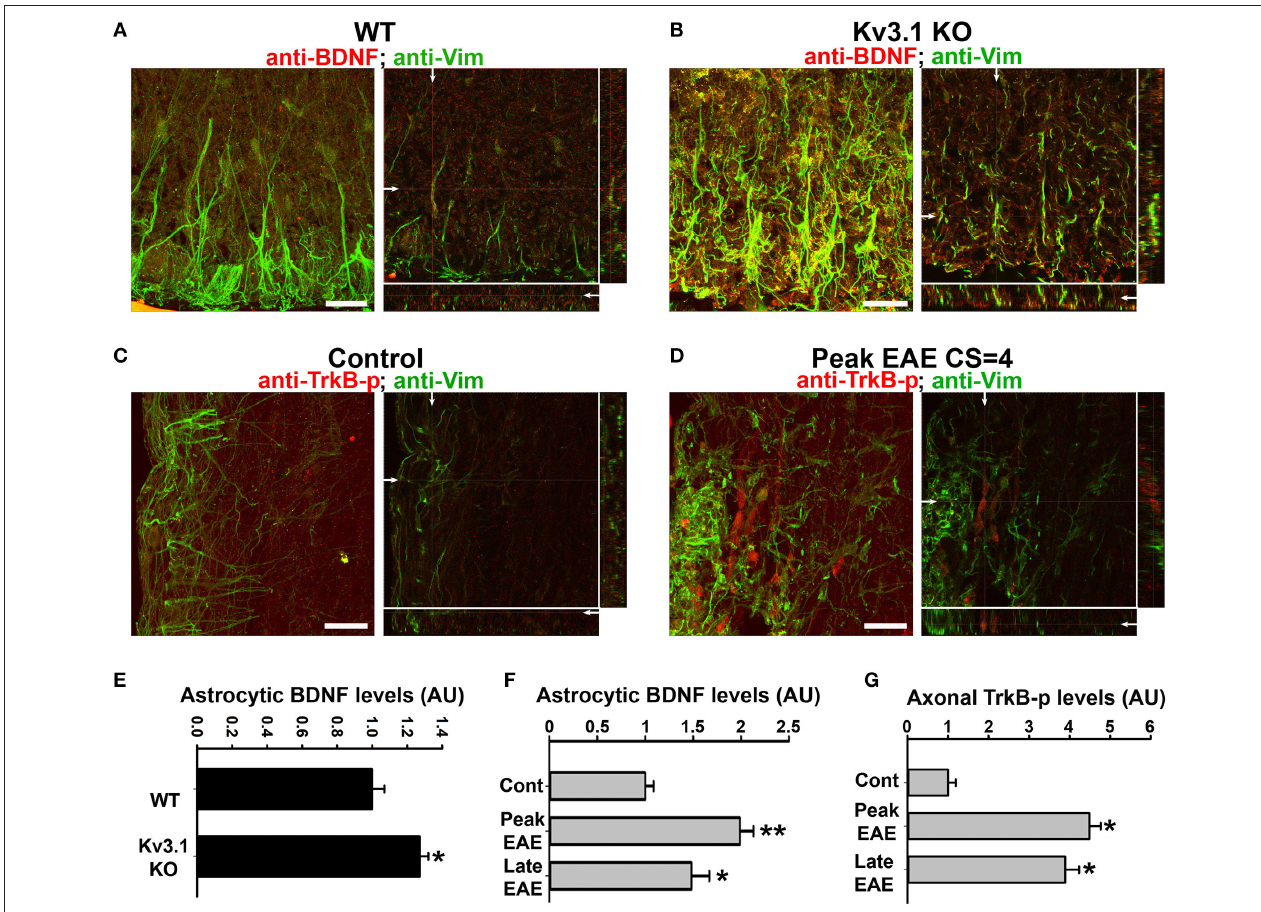
FIGURE 5 | Alterations of BDNF and Trk receptor levels in Kv3.1 KO mice and EAE mice. The levels of BDNF (red) and Vim (green) in SCWM of WT (A) and Kv3.1 KO (B) mice. High magnification confocal image stacks were obtained from cross sections of ventral SCWM. The collapsed 2D images are on the left, and three cross sections are on the right. Scale bars, 200 µ m. The levels of phospho-TrkB (TrkB-p) receptors (red) and Vim (green) in the control (C) and peak EAE (D) stages of WT mice. The image stacks were captured from longitudinal sections of SCWM. (E) The BDNF level significantly increased in Vim-positive astrocytes in SCWM of Kv3.1 KO mice. Unpaired Student t –test: * p < 0.05. (F) BDNF levels in Vim-positive astrocytes at different stages of EAE in WT mice. (G) Axonal pan-Trk levels increased during EAE. One-way ANOVA followed by Dunnett’s test in (F,G) . ** p < 0.01; * p < 0.05. n =